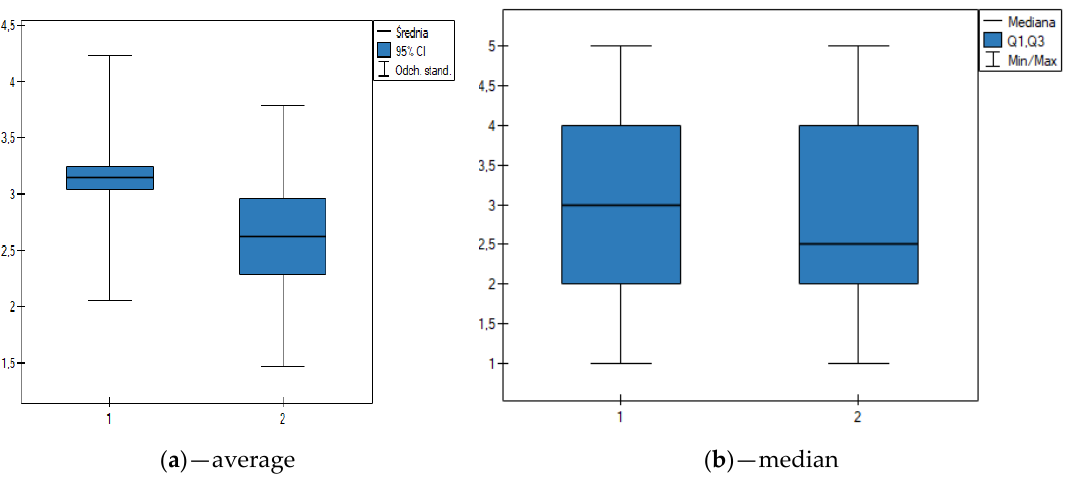
Figure 3. The Mann–Whitney U test for the dependence between gender and the belief that it is safe for children to take dietary supplements if they are administer according to the recommendations (1—women, 2—men, y axis is the 5-point scale where 5 means ‘I strongly agree’ and 1 means ‘I strongly disagree’. Statistically significant differences at p ≤ 0.05.